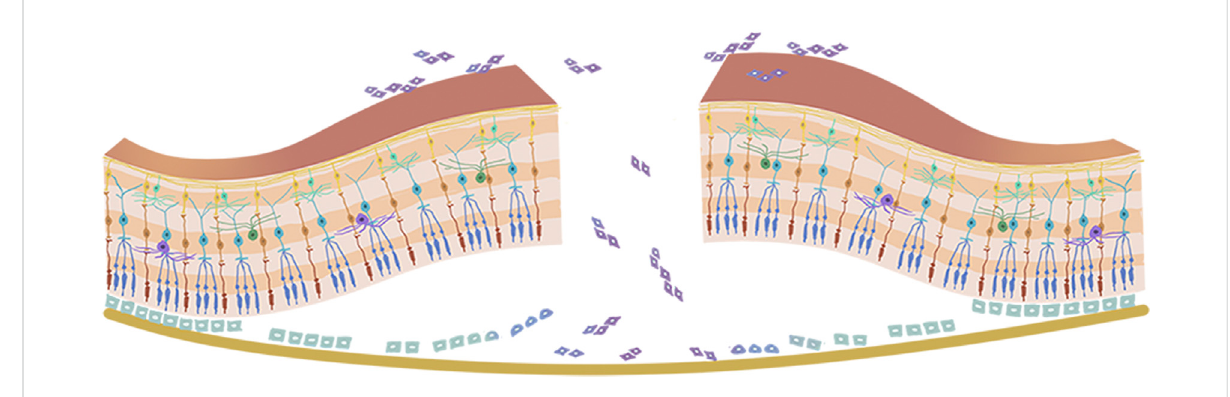
FIGURE 2 Pathophysiologyofproliferativevitreoretinopathy.Theretinalpigmentepitheliumcellslosecell-cellcontact,anddiffuseintothevitreouscavity via retinal breaks, then go through epithelial-mesenchymal transition (EMT) and eventually transform into myo fi